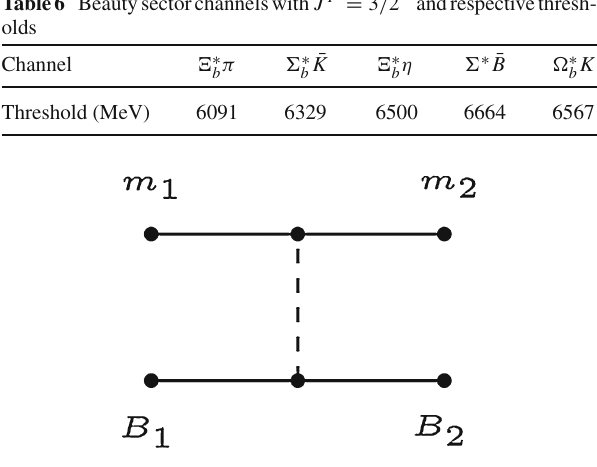
Fig. 1 Example of a type of diagram that arises from the